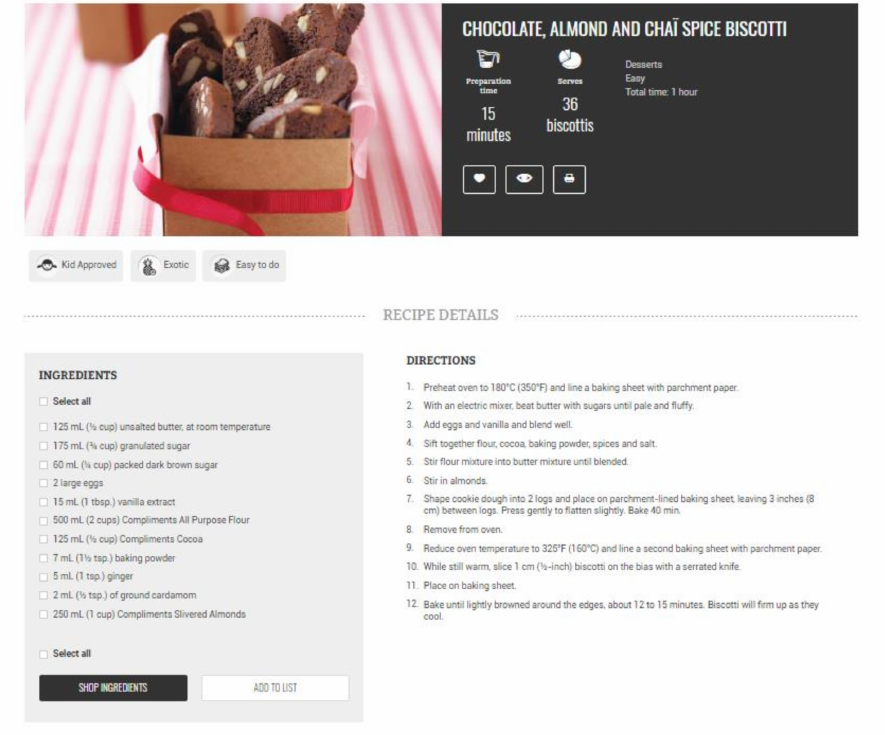
Figure A1. Recipe used for the condition with Low arithmetic complexity and search